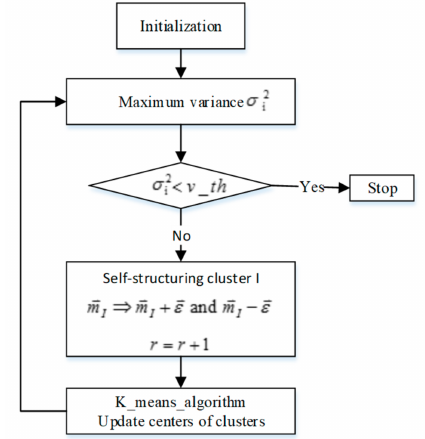
Figure 7. The flow chart of self-structuring rule generation